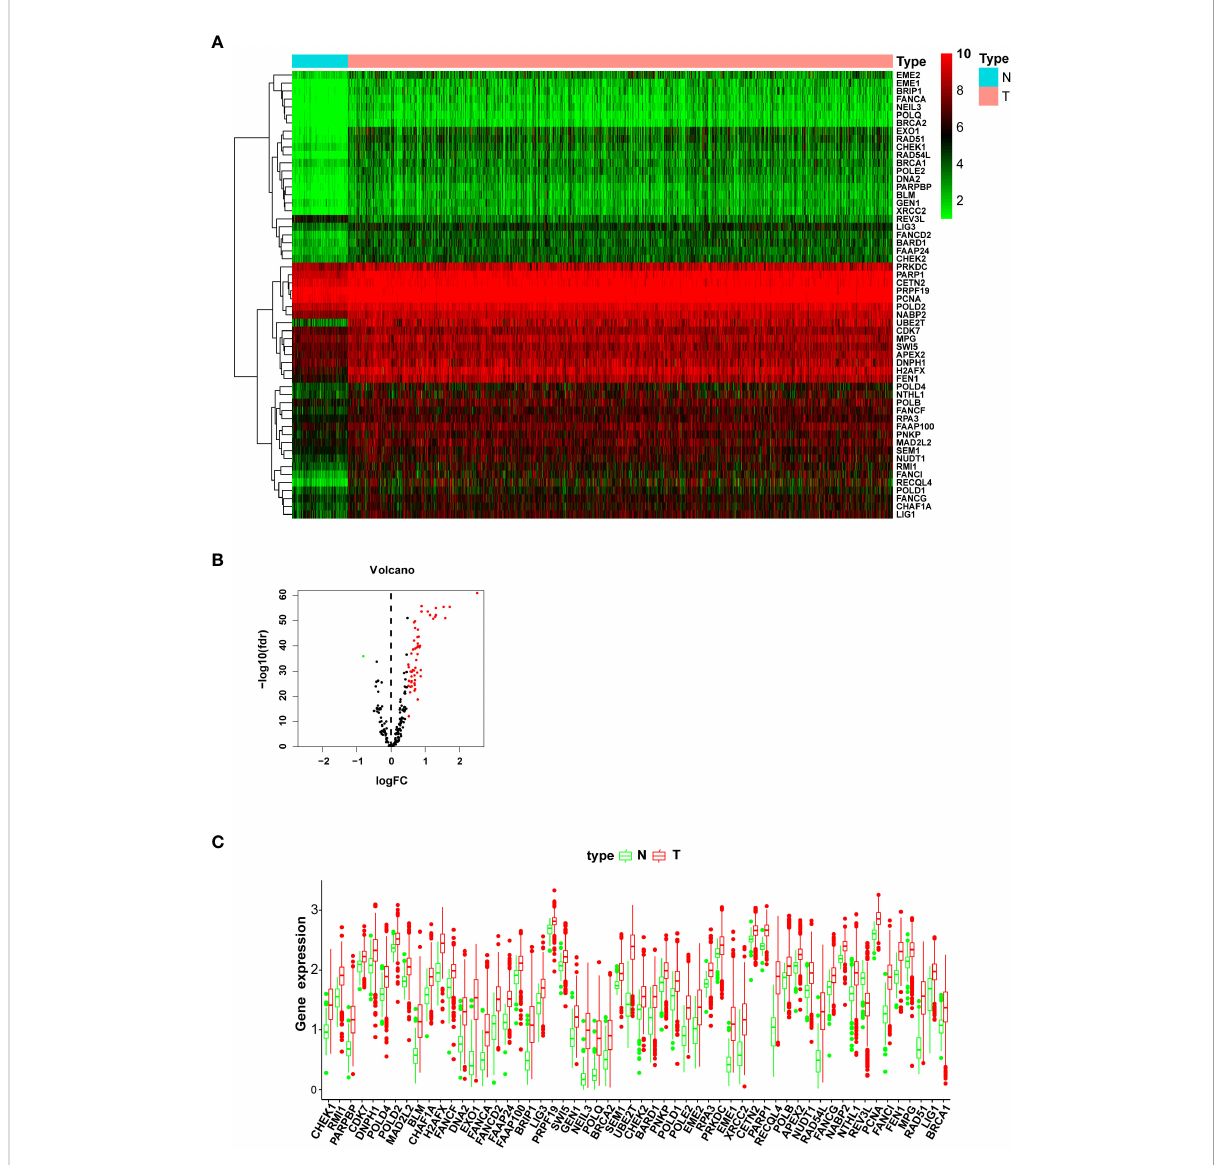
FIGURE 1 The expression level of differentially expressed genes (DEGs) between the normal and tumor groups. (A) The heatmap shows the expression levels of DEGs; downregulated genes are shown in green, and upregulated genes are presented in red. (B) The volcano plot presents the expression levels and expression fold changes of DEGs; one downregulated gene is shown as a green dot; 55 unregulated genes are presented as red dots. (C) The box bar presents the expression levels of DEGs in normal and tumor